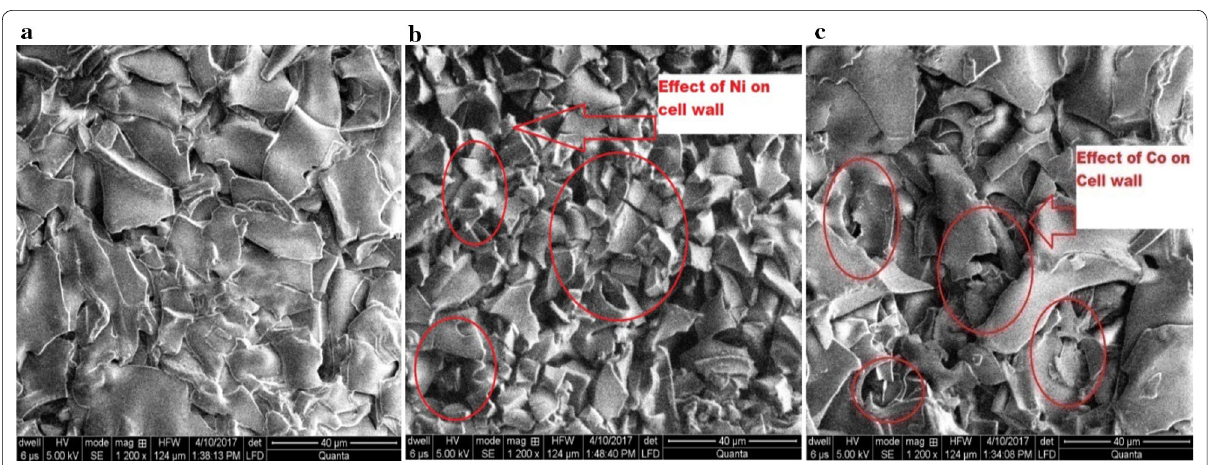
Fig. 4 a Electron micrograph of Klebsiella variicola strain AMIC 1 without metal stress, b with Ni, c with